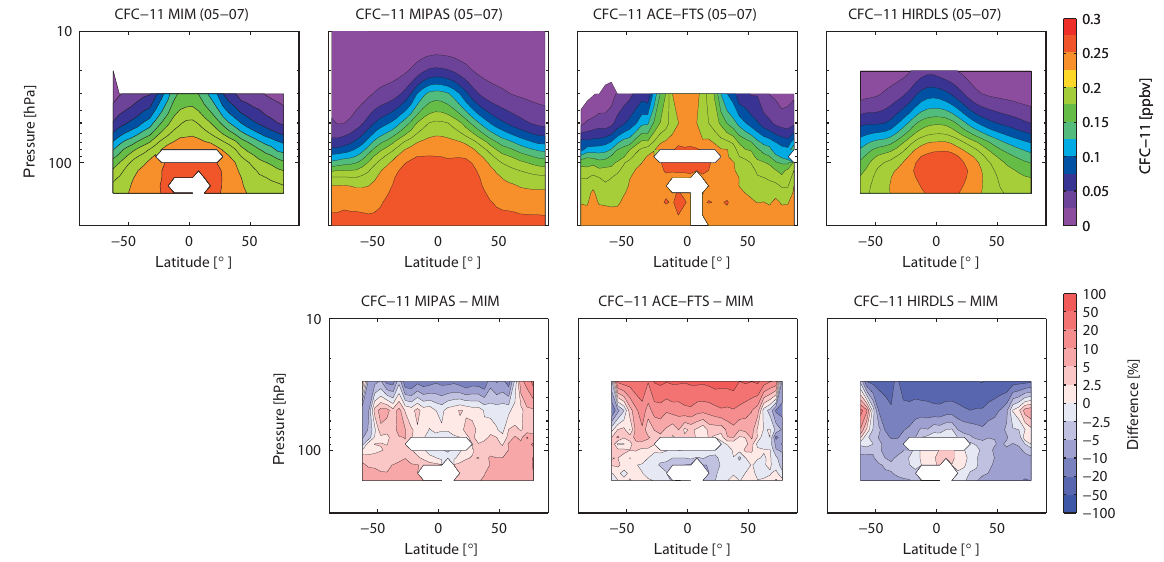
Figure 1. Altitude–latitude cross sections of annual zonal mean CFC-11 for the MIM, MIPAS, ACE-FTS and HIRDLS (upper panels) and relative differences between the individual instruments and the MIM (lower panels) are shown for 2005–2007.